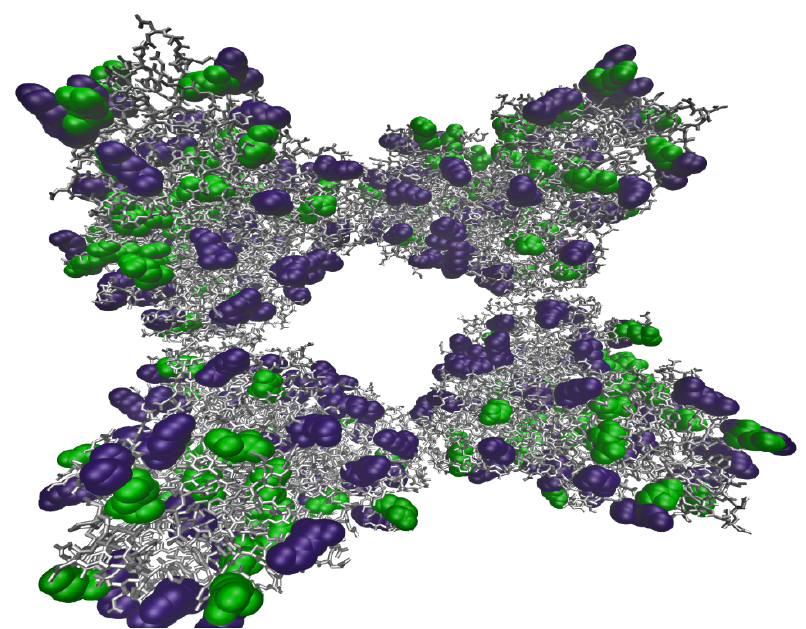
Figure 5. Molecular model of invertase from Saccharomyces cerevisiae with underlined Lys (purple) and Gln (green) residues.